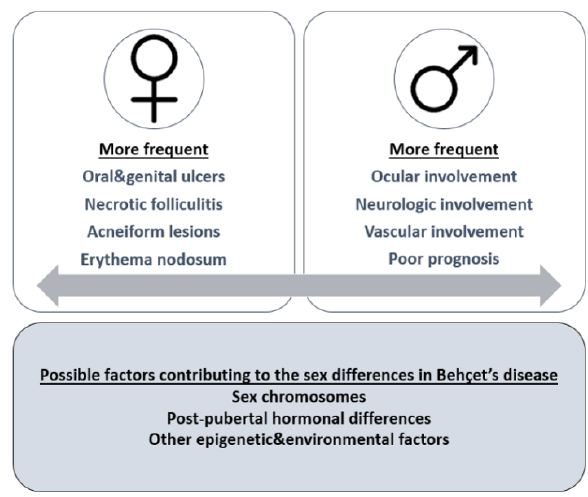
Figure 1. Summary of sex-related differences and disease presentation in Behçet’s disease Scientific Hypotheses and Their